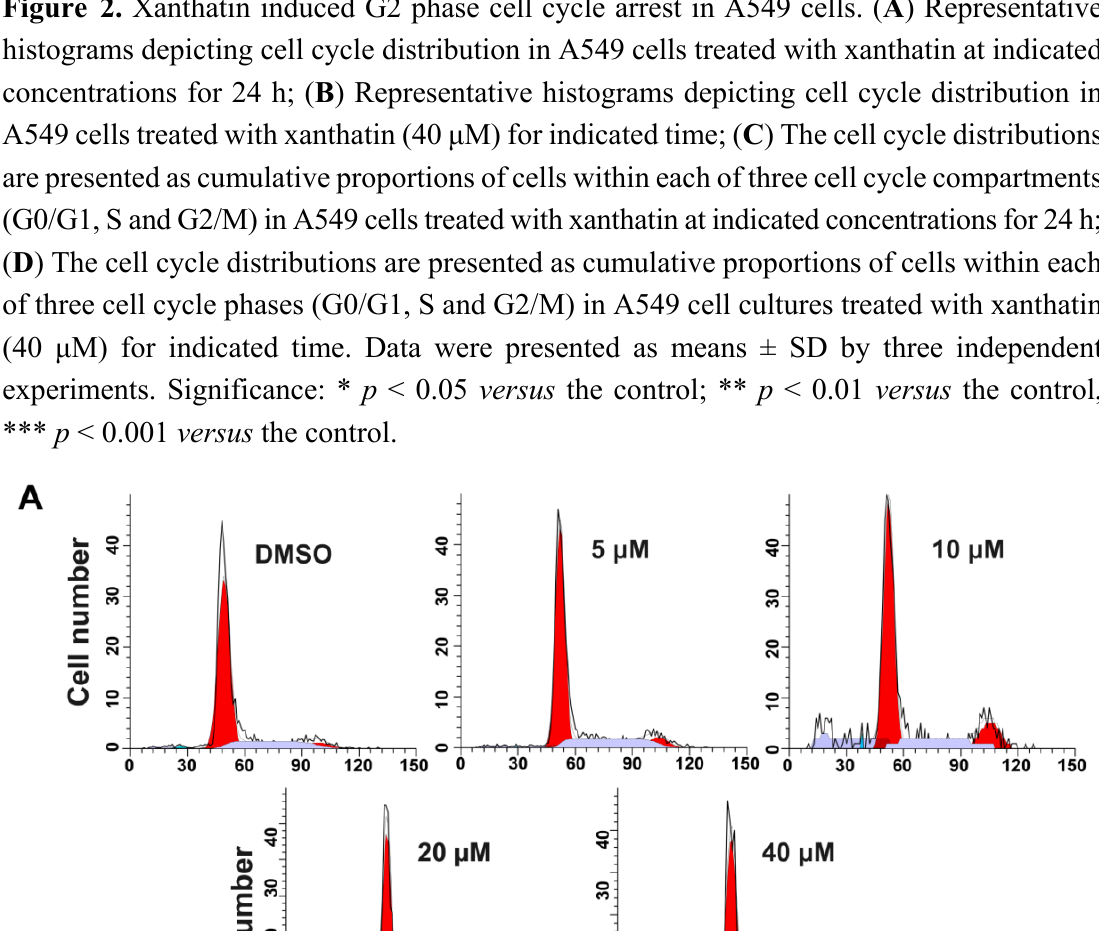
Figure 2. Xanthatin induced G2 phase cell cycle arrest in A549 cells. ( A ) Representative histograms depicting cell cycle distribution in A549 cells treated with xanthatin at indicated concentrations for 24 h; ( B ) Representative histograms depicting cell cycle distribution in A549 cells treated with xanthatin (40 μ M) for indicated time; ( C ) The cell cycle distributions are presented as cumulative proportions of cells within each of three cell cycle compartments (G0/G1, S and G2/M) in A549 cells treated with xanthatin at indicated concentrations for 24